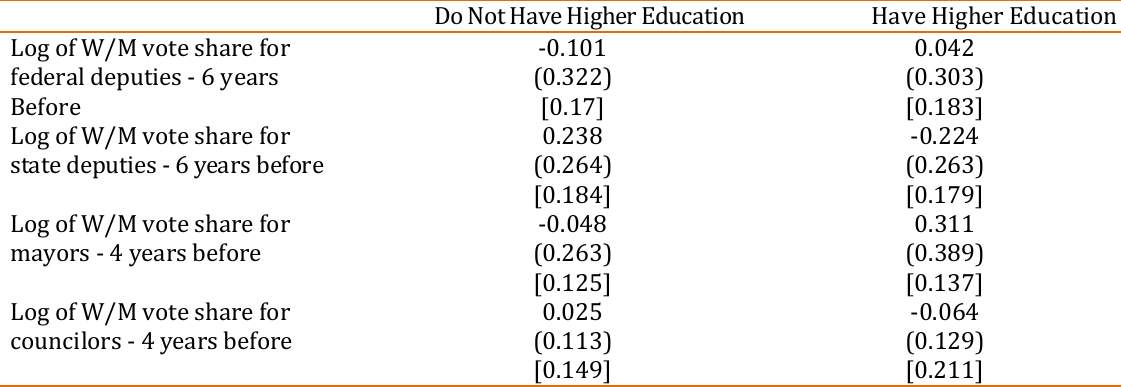
Table 04. Balance test for lagged dependent variables by educational level Do Not Have Higher